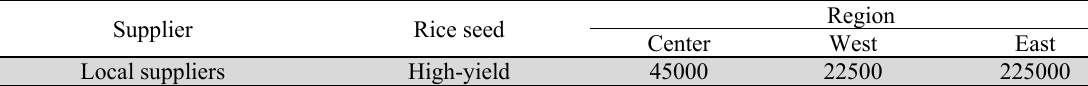
Amount of seed (kg) supplied to each region